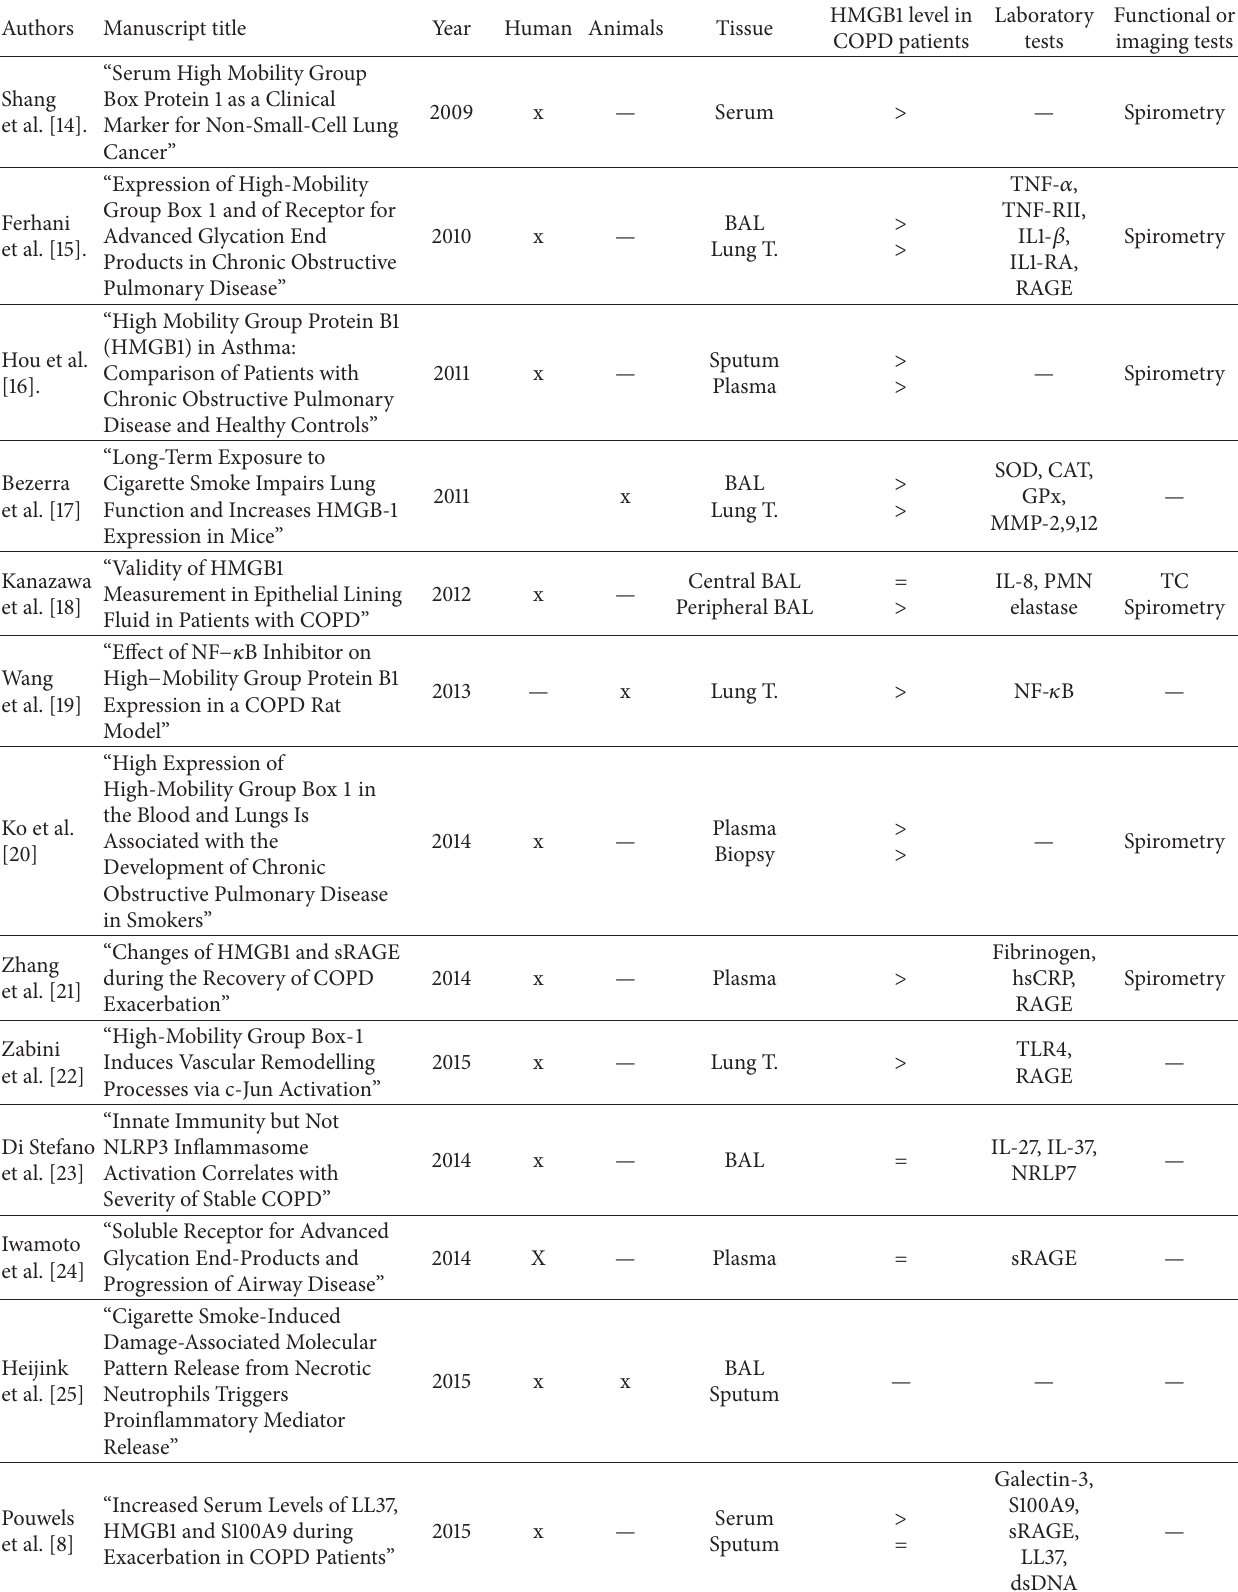
Table 2: Studies evaluating HMGB1 in the pathogenesis of